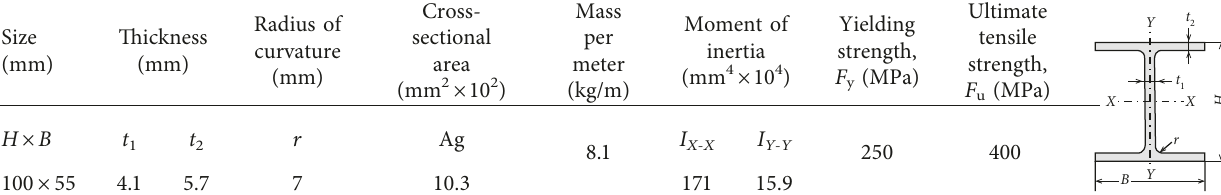
Table 1: Dimension and properties of the steel section ∗